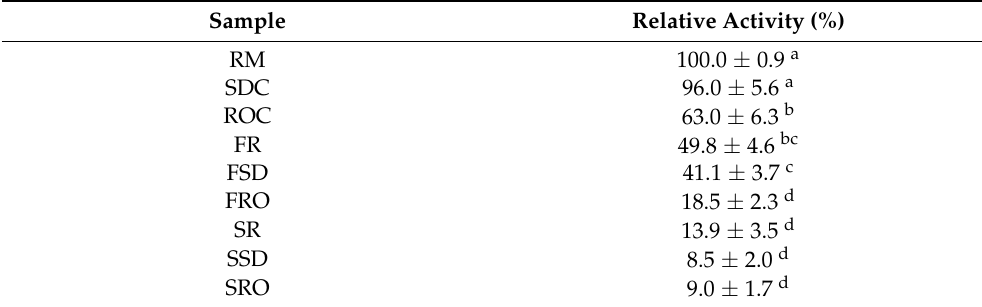
Table 2. Change of lactoperoxidase (LPO) activity during concentration and dehydration of camel